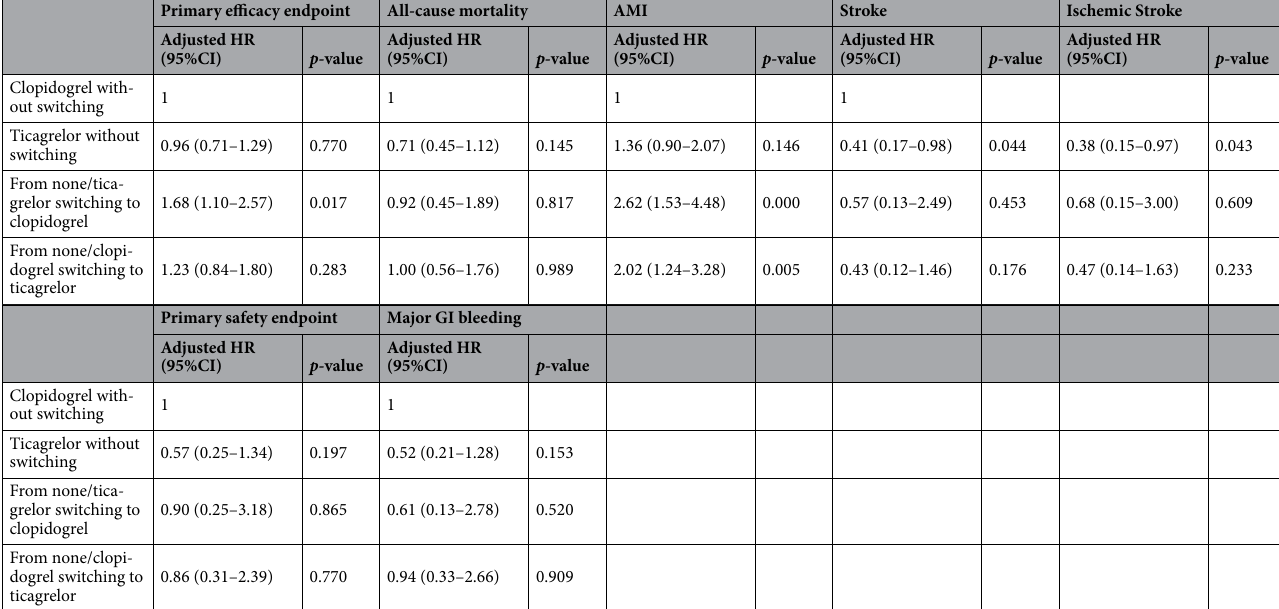
Table 4. Subgroup analysis of the effect of drug switching strategies on the occurrence of the primary efficacy and safety